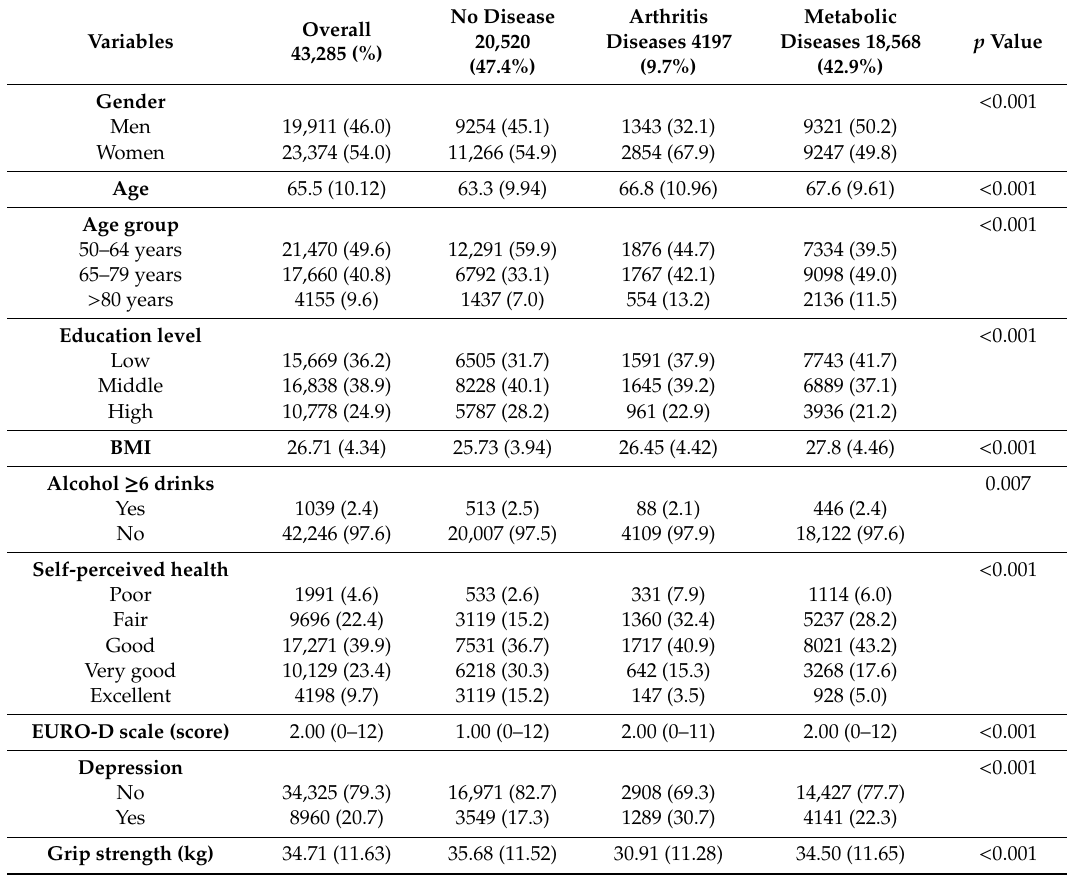
Table 1. Participants’ characteristics ( n =